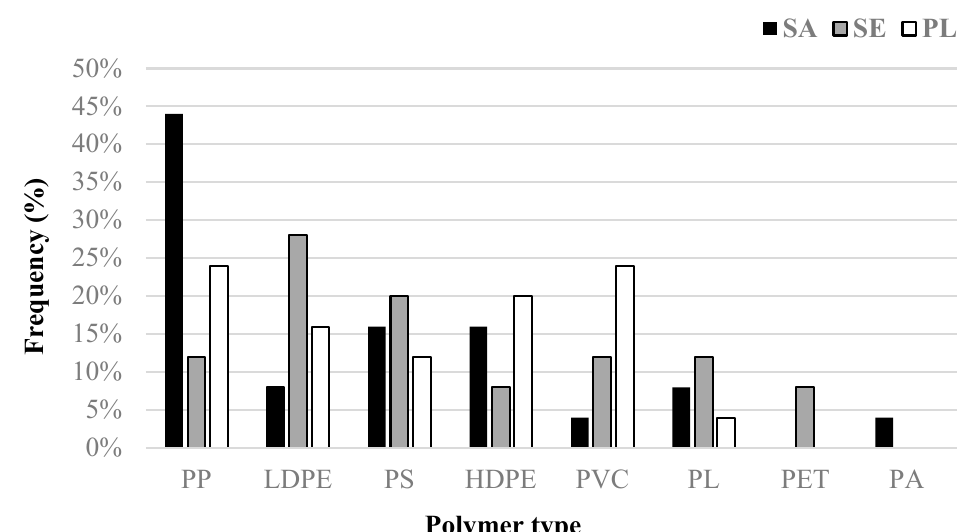
Figure 2. Frequency (%) of plastic polymers found by FTIR analysis ( n = 75) of plastic items collected in the three stations (PP: polypropylene, LDPE: low-density polyethylene, PS: polystyrene, HDPE: high-density polyethylene, PVC: polyvinyl chloride, PL: polyester, PET: polyethylene terephthalate, PA: polyamide). Stations names are abbreviated as follows: SA (Sant Antoni de Portmany), SE (Santa Eulària), PL (Pou des Lleó).